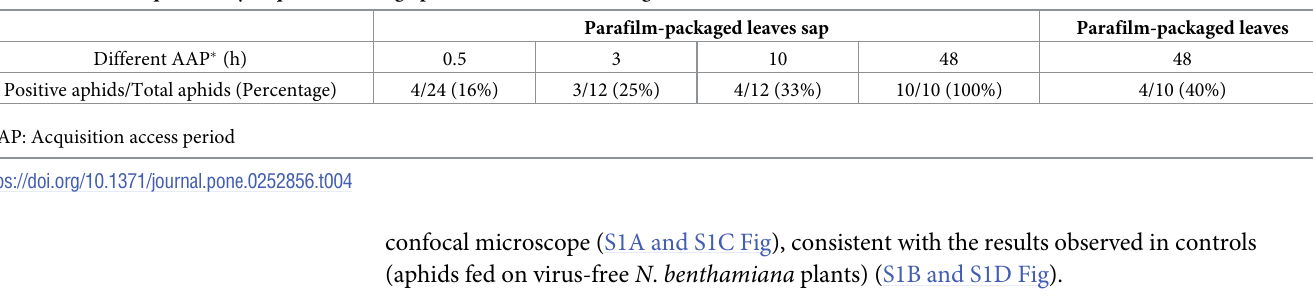
Table 4. CGMMV acquisition by M . persicae through parafilm membrane